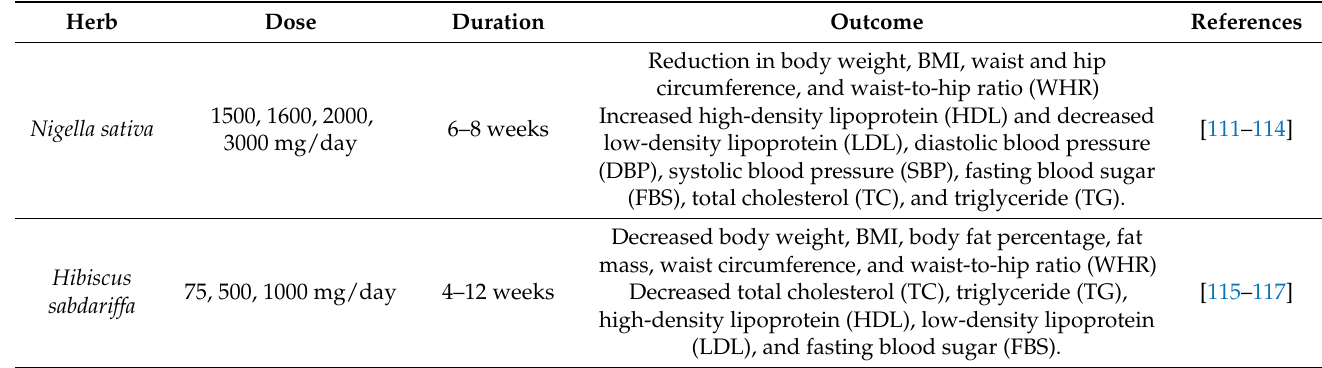
Table 1. Clinical trials on herbs for the treatment of obesity in